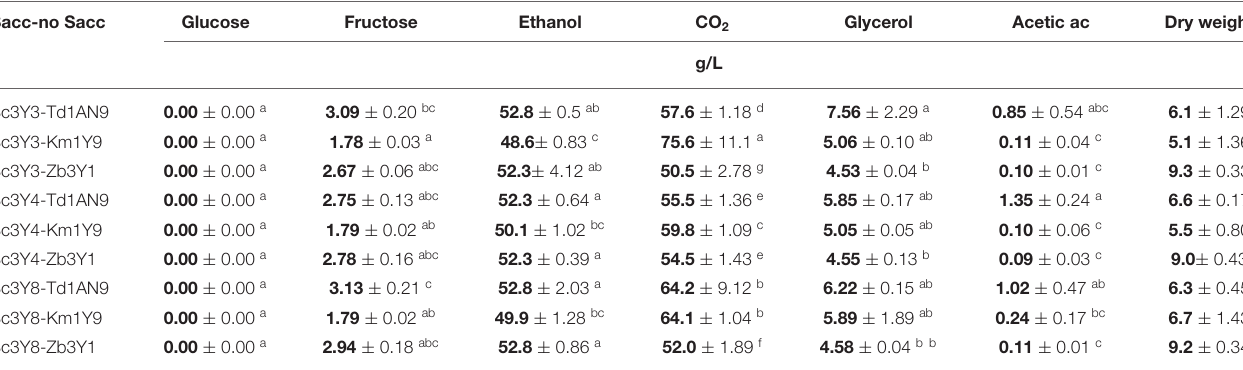
TABLE 4 | Primary metabolite profiles and hexose consumption for the mixed cultures at 96h in Agave medium. Sacc-no